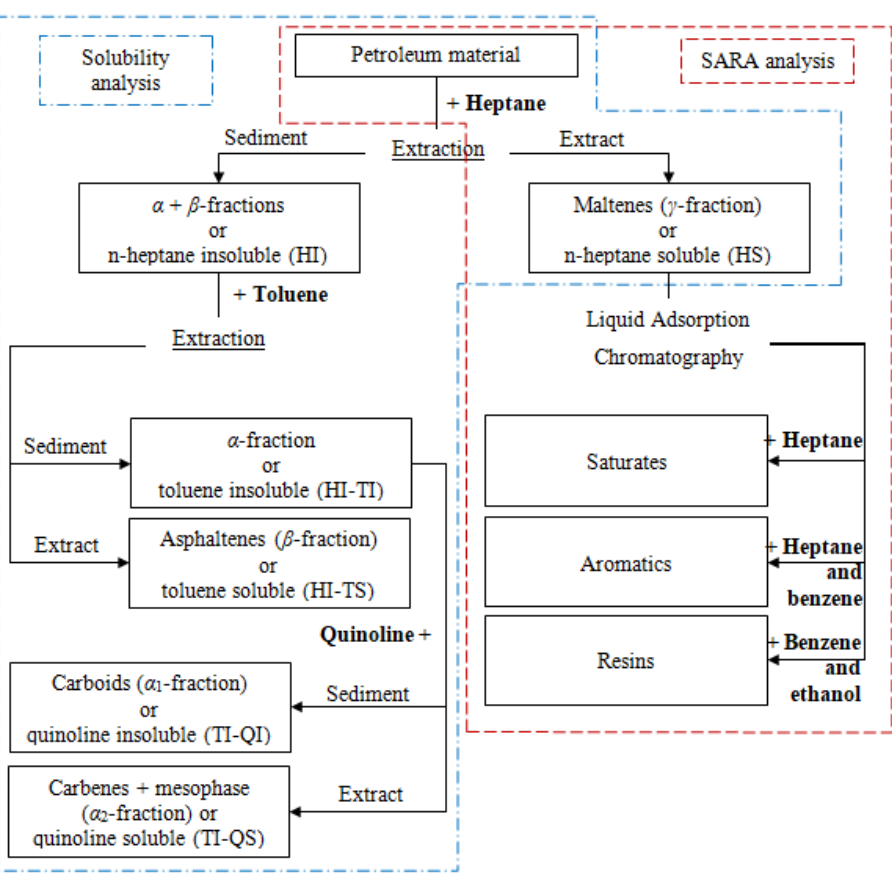
Figure 3. Flowchart of the complex analysis of the group chemical composition by solubility accord- ing to the SARA method.